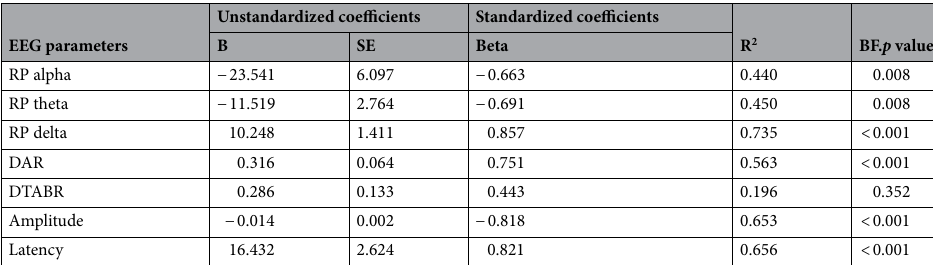
Table 2. Univariate linear regression analysis for stroke lesion volume. BF. p value indicates Bonferroni corrected p values. The BF. p values were calculated by multiplying p values by the number of the tests using R software 75 . The residual errors for each model showed normal distribution on a Shapiro–Wilk test ( p value >